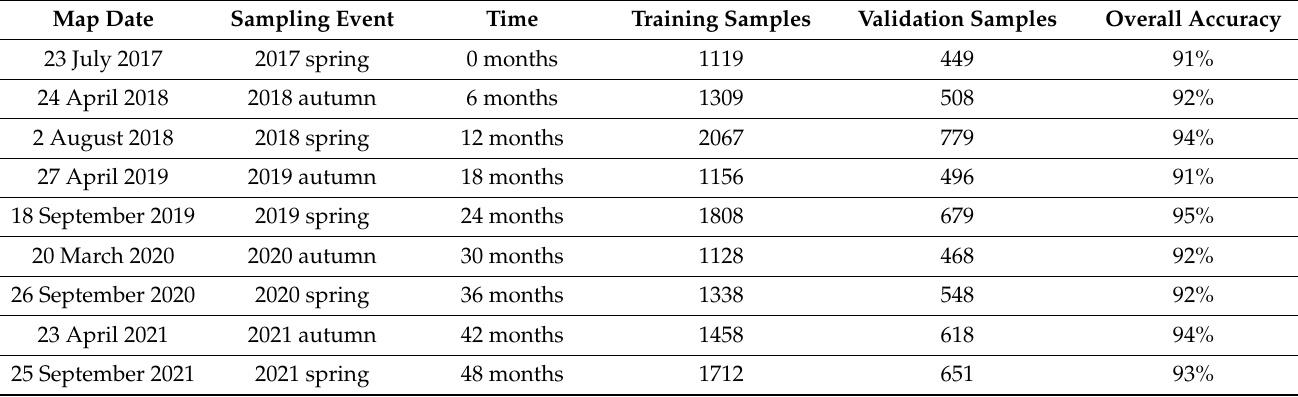
Table 2. Summary of training samples, validation samples and overall accuracy for each correspond- ing land cover